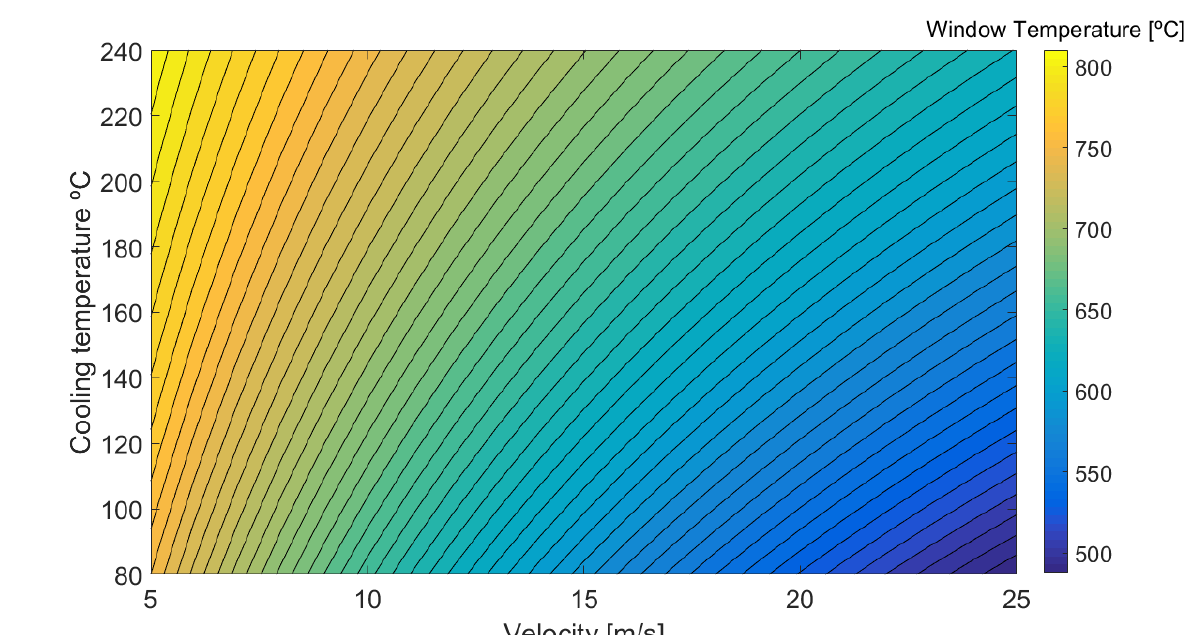
Figure 11. Contour plot of window temperature dependent of cooling gas injection velocity and temperature.